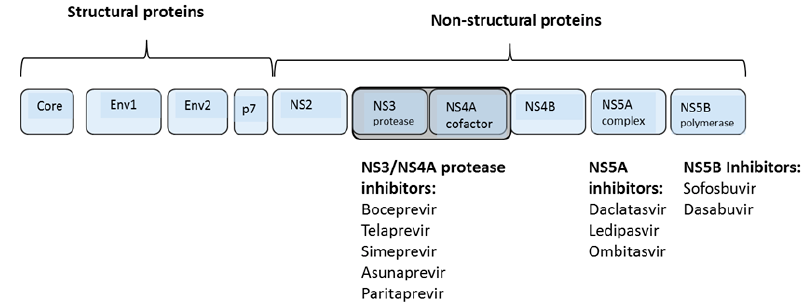
Figure 1. HCV genome architecture and DAA targets. The HCV RNA genome is initially translated as a polyprotein which is initially cleaved by host proteases after which the NS3/NS4A protease cleaves itself and the remaining nonstructural proteins. Direct acting antivirals have been developed against the NS3 protease, the NS5A replication complex, and the NS5B polymerase.